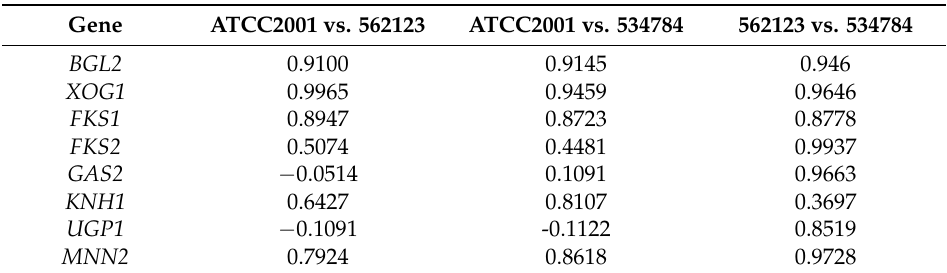
Table 4. Pearson Correlation Coefficient (r) determined for the expression profiles of BGL2 , FKS1 , FKS2